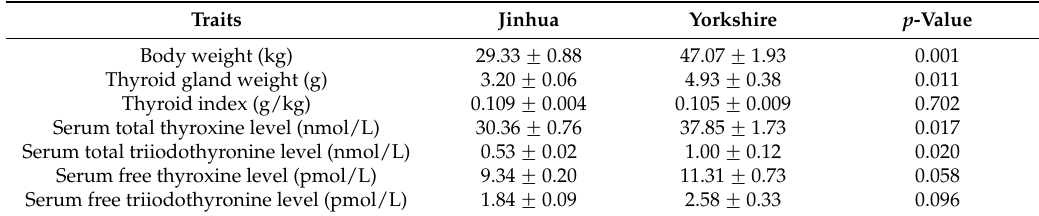
Table 1. Body Index and serum concentration of thyroid hormones (THs) in the Jinhua and Yorkshire pig breeds.